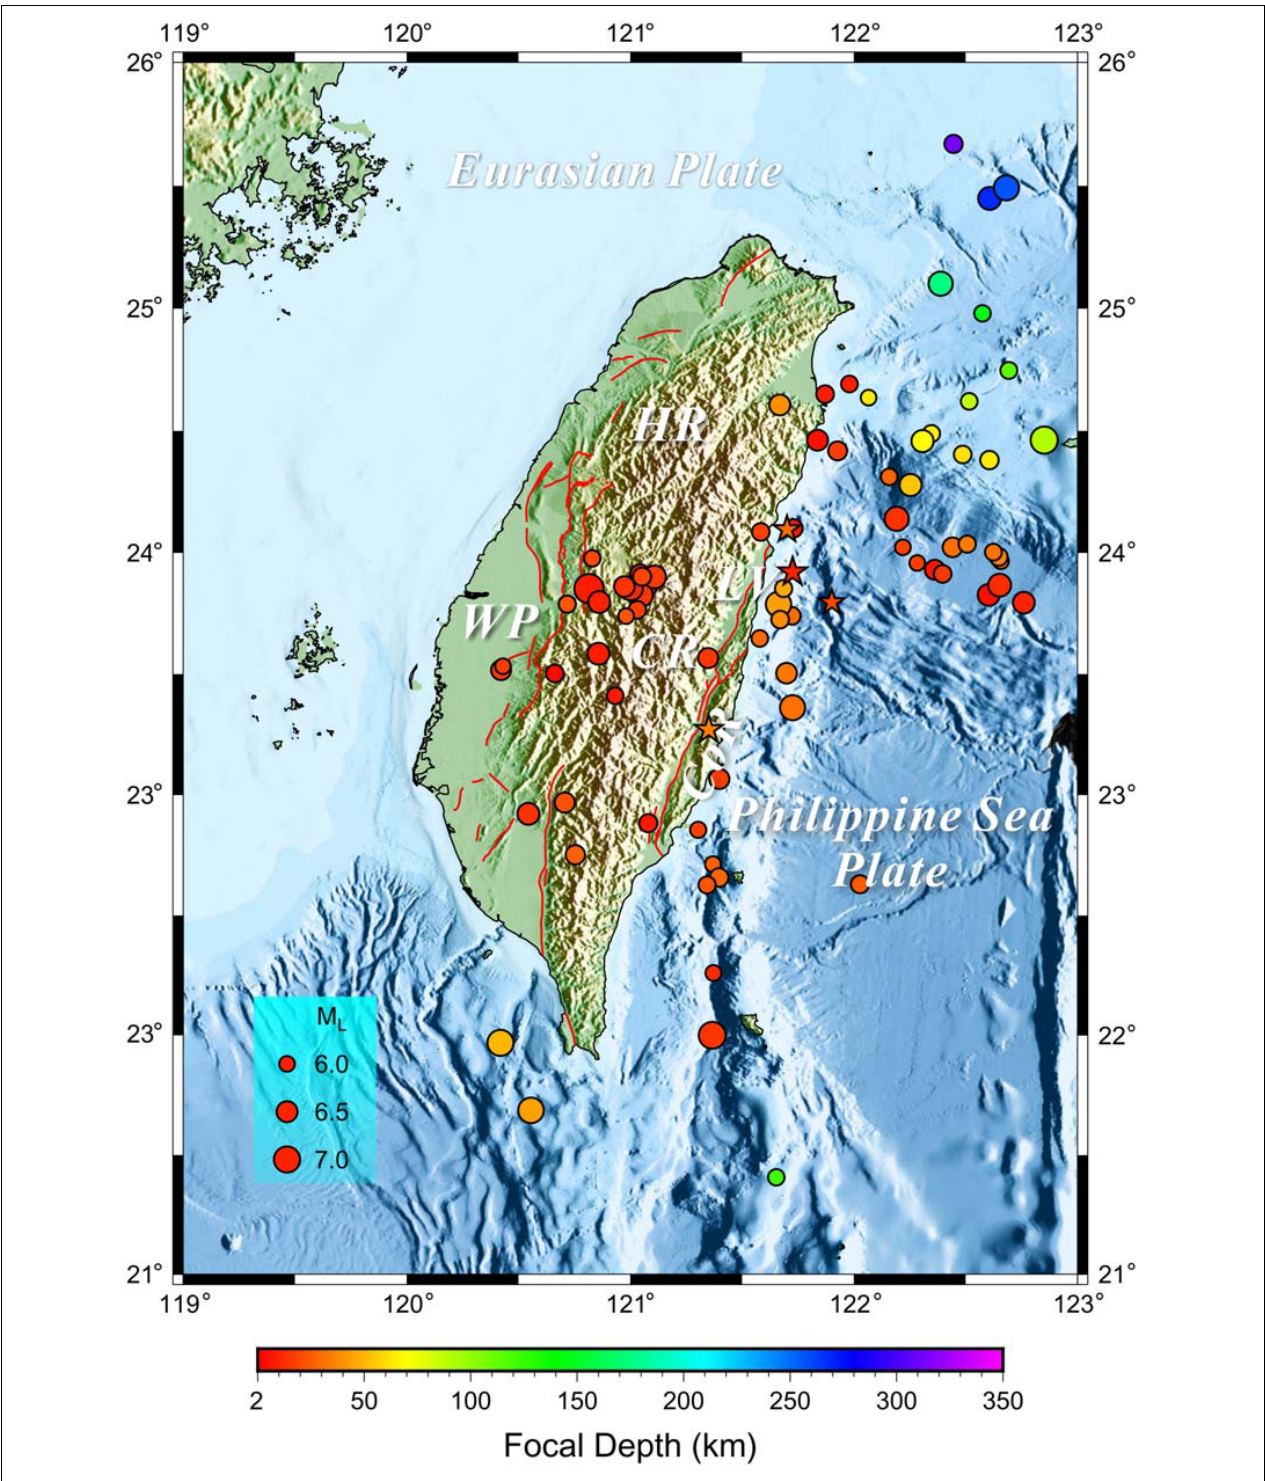
FIGURE 1 | Distribution of the large earthquakes greater than ML 6.0 which occurred in the Taiwan area in the past 28 years (1991–2018). Symbol size represents the magnitude, whereas the color indicates the earthquake focal depth. Although more than a half of the earthquakes occurred in the offshore area, there were still 26 damaging large earthquakes ruptured underneath the inland Taiwan. Epicenters with ML > 7.0 in the 1951 Longitudinal Valley Sequence are shown in red starts. Red lines mark the surface traces of 33 active faults, which were announced by the Central Geological Survey of Taiwan. Geological terranes: WP, western coastal plain and foothills, HR, hsuehshan range, CR, central range, LV, longitudinal valley, CoR, coastal range.